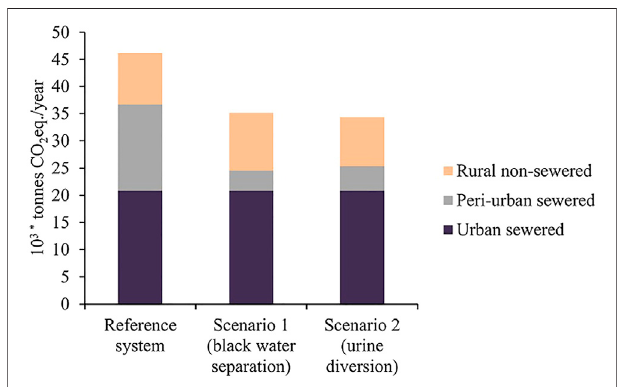
FIGURE 3 | Climate change impact (tonnes CO 2 eq./year) of Reference System and de fi ned source separation Scenarios 1 and 2 as well as the contribution of urban, rural and peri-urban